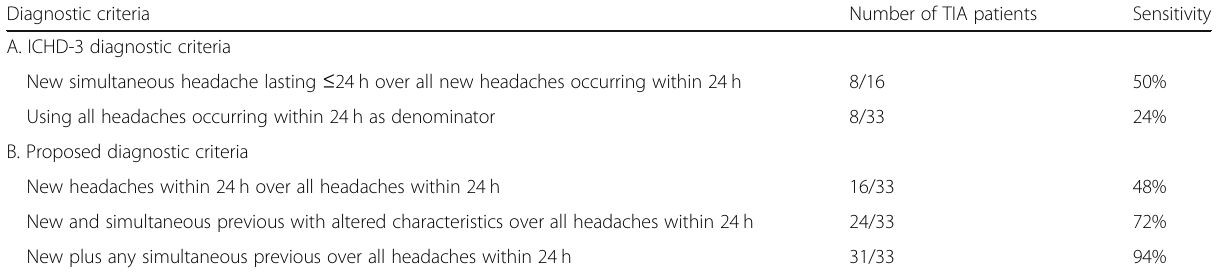
Table 2 Sensitivity calculations for ICHD-3 diagnostic criteria and proposed diagnostic criteria Diagnostic criteria